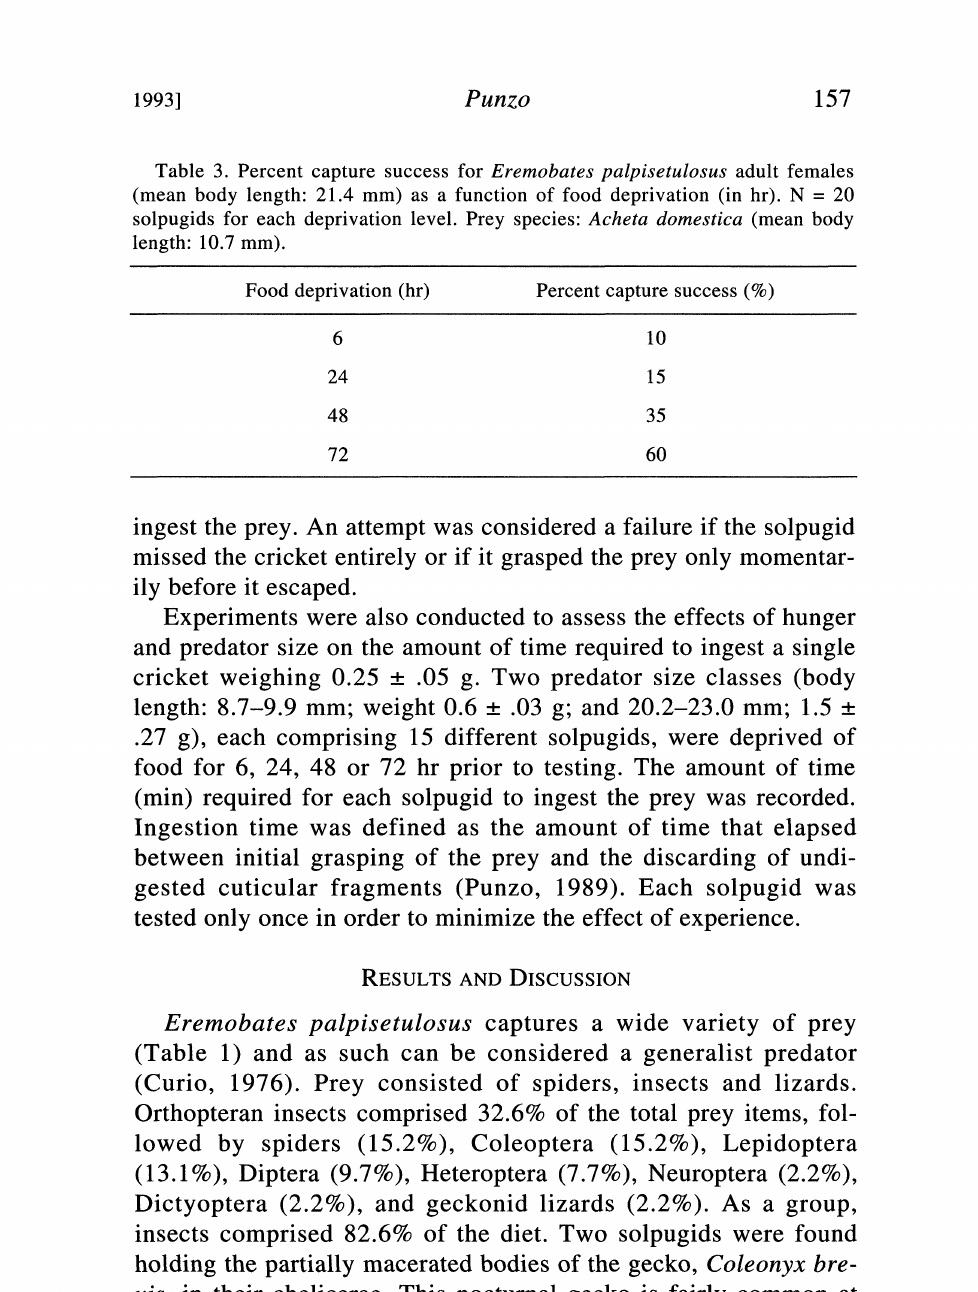
Table 3. Percent capture success for Eremobates palpisetulosus adult females (mean body length: 21.4 mm) as a function of food deprivation (in hr). N 20 solpugids for each deprivation level. Prey species: Acheta domestica (mean body length: 10.7